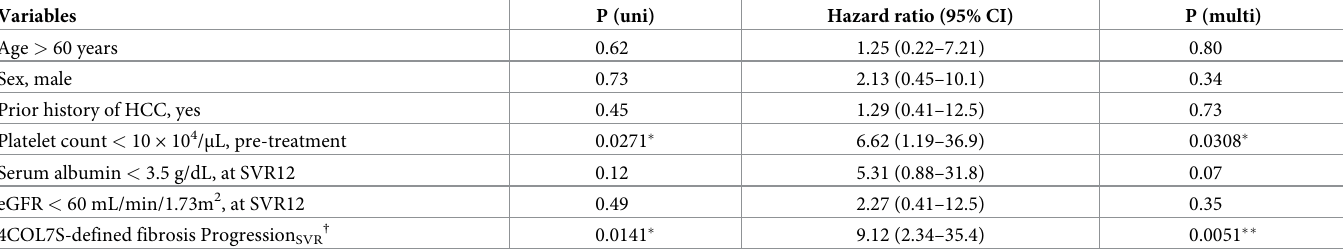
Table 2. Cox proportional hazard model for factors associated with all-cause mortality in patients whose baseline serum 4COL7S � 6.1 ng/mL (N = 163 with nine censored events).